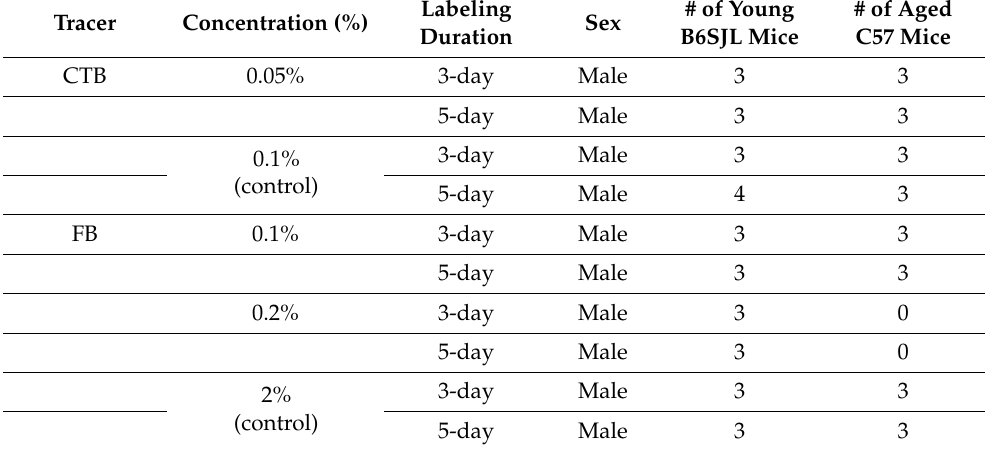
Table 1. Young WT (B6SJL, 6–7 weeks) and aged (C57Bl/6, 25 months) male mice were assigned to different tracer protocols each representing a given tracer (FB or CTB) at a given concentration (% weight/volume) and labeling duration (3-day or